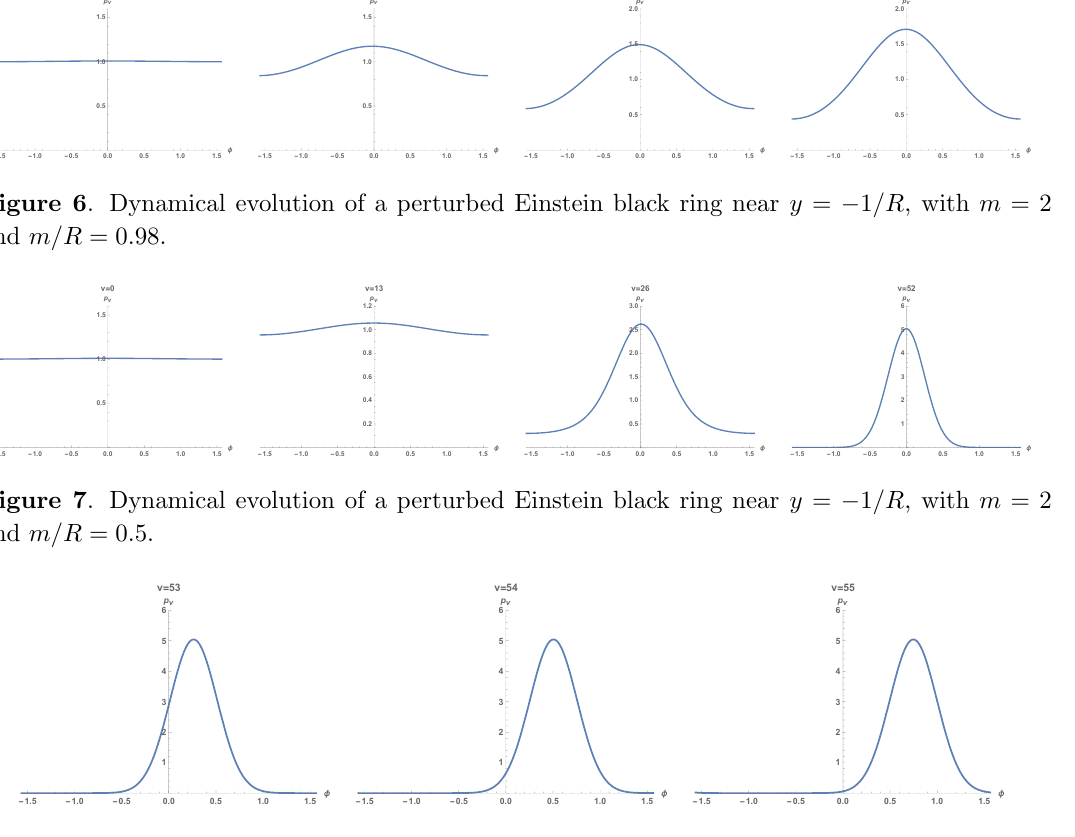
Figure 8 . The subsequent behavior of the evolution of a perturbed Einstein black ring near y = (cid:0) 1 =R , with m = 2 and m=R = 0 :